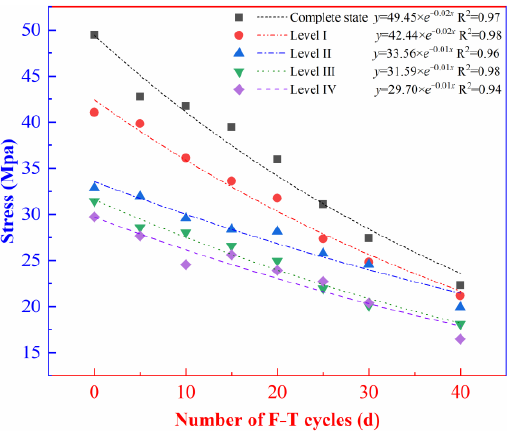
Figure 7. Scatter plot of the number of F-T cycles and peak stress